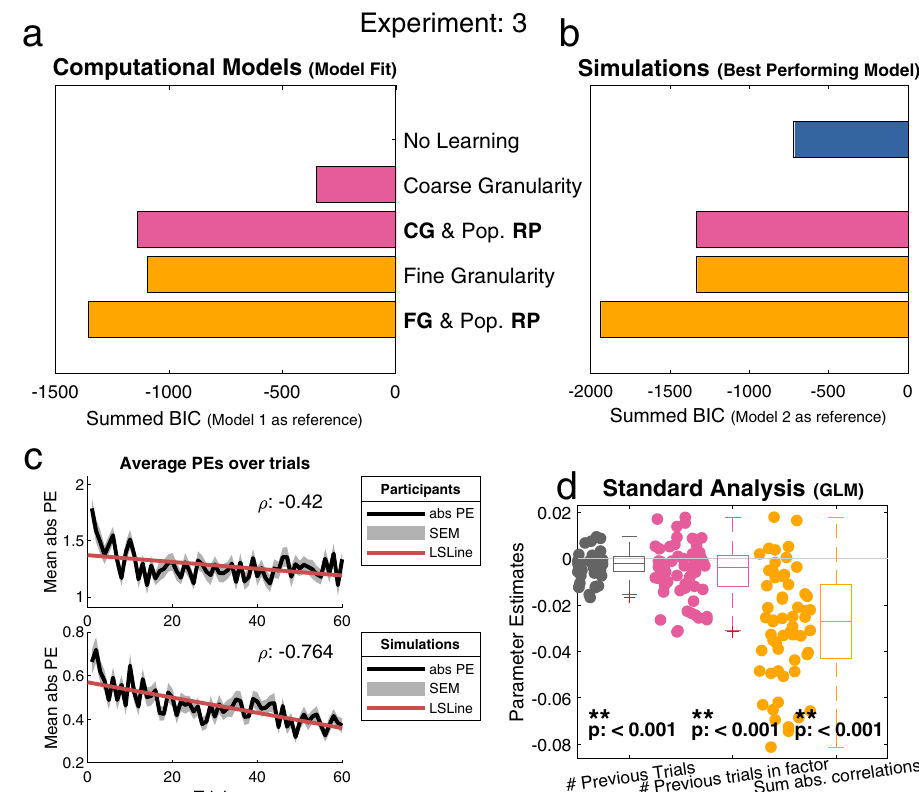
Fig. 5 | Overview of the main analyses for Experiment 3. In this experiment participants learned about real pro fi les on two Big-Five factors. Results indicate participants ’ use of a fi ne correlation structure. a Similar to experiment 1, Model 5 [Fine Granularity & Population RP] is the best fi tting model for experiment 3 ( n =59). This model uses the average population as a reference point and fi ne granularity for generalization. b Simulated data to fi nd the best performing model ( n =59). In line with results from the participants, model 5 [Fine Granularity & Population RP] was the best performing model, demonstrating that participants used the best possible strategy. c Both plots display the average absolute PEs over time±SEM. Top) Participants ’ data shows a decrease in the PEs over time ( ρ : − .42, least squares line (red)), which indicates that participants learned over time. Bot- tom)Simulateddatafromthebest fi ttingmodel(Model5)alsoshowsadecreasein PEs over time ( ρ : − 0.764), showing that the models learned in a similar way to